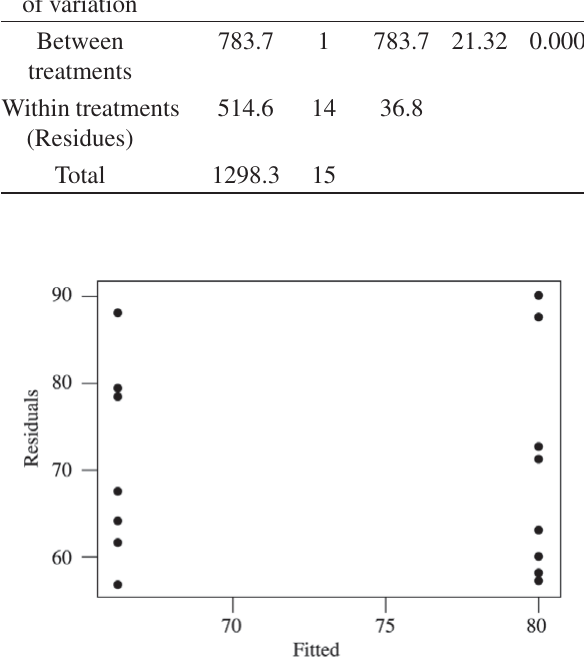
Figure 5. Residues versus estimated